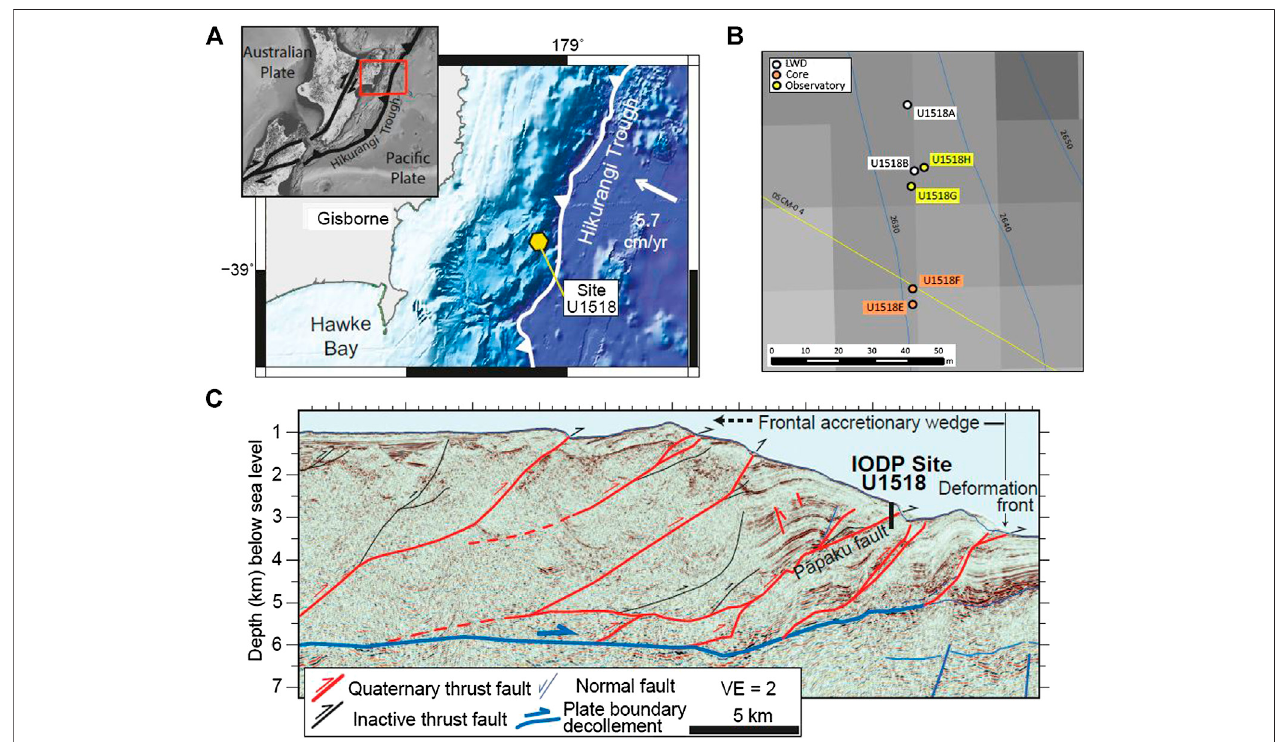
FIGURE1|(A) LocationandgeotectonicsettingoftheHikurangisubductionmarginandtheNewZealandplateboundary(inset).Displayedinthebathymetricmap ofthenorthernHikurangisubductionmarginarealsothemainthrustfaults,IODPSiteU1518andtherelativeplateconvergencevector (B) Detailedlocationmapofholes drilled at Site U1518 (from Saffer et al., 2019) (C) Seismic cross section of the frontal accretionary wedge near the drilling transect of IODP Expedition 375, including interpretationafterBarkeretal.(2018).ThelocationofIODPSiteU1518andtraceoftheP (cid:1) apakufaultareindicated.Figures (A) and (C) aremodi fi edfromFagereng et al. (2019) and Greve et al.